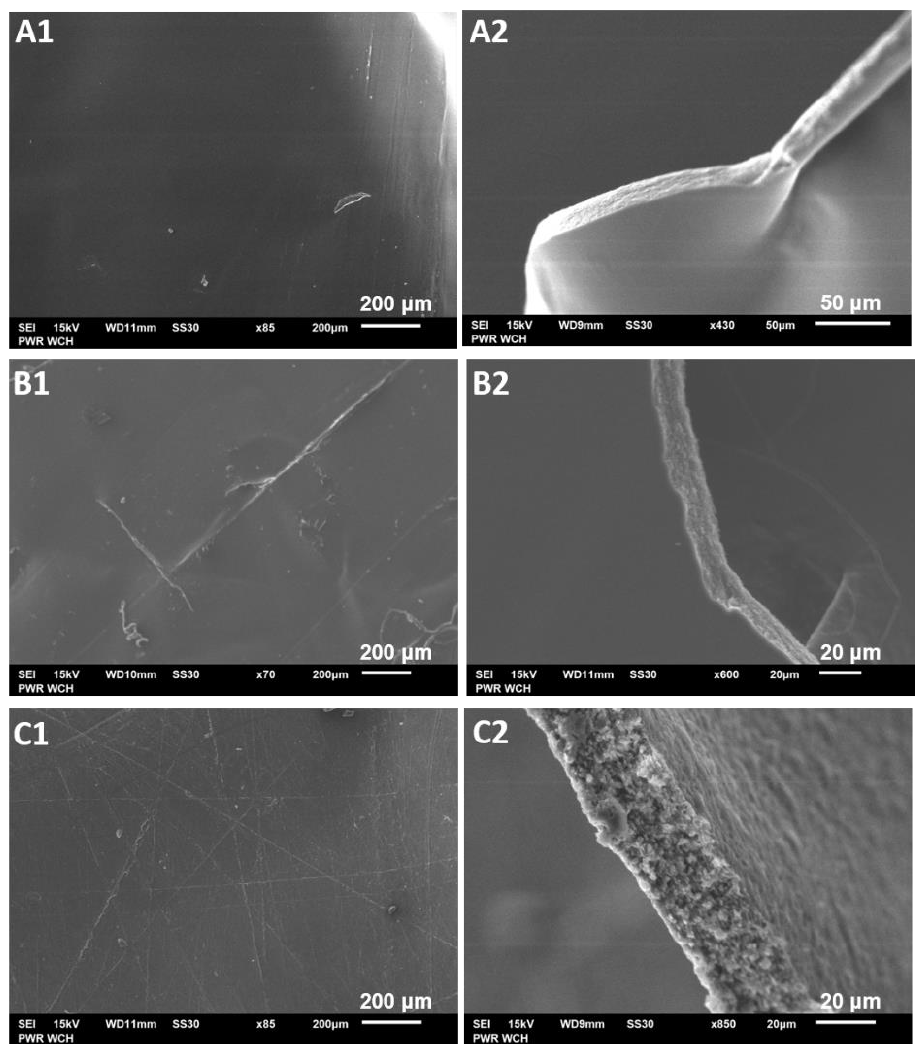
Figure 6. SEM images of ( A1 ) unloaded film; ( A2 ) cross section of unloaded film; ( B1 ) enzyme- loaded film; ( B2 ) cross section of enzyme-loaded film ( C1 ) enzyme-loaded film after 35 usage cycles. HPMC:CS = 2:1; ( C2 ) cross section of enzyme-loaded film after 35 usage cycles.